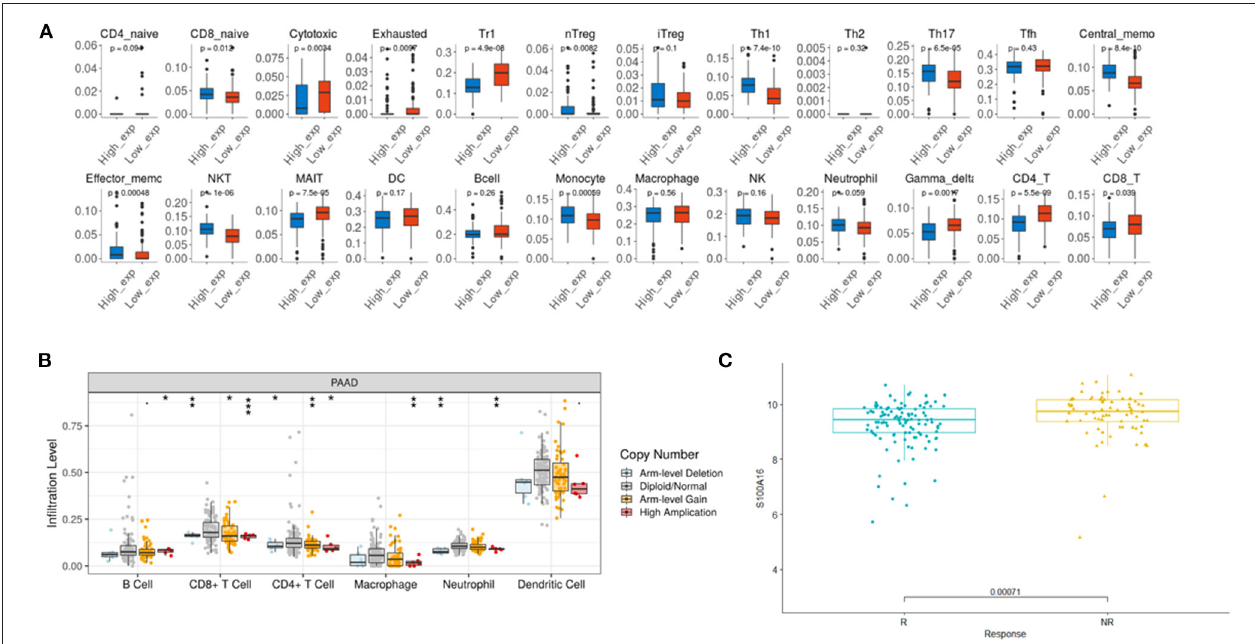
FIGURE 14 | Immune CellAI for S100A16 based on the TCGA database. (A) The relationship between the S100A16 copy number variation and infiltration level. * P < 0.05; ** P < 0.01; *** P < 0.001 (B) . ICB response prediction showed the predicted outcome of immune checkpoint treatment response (C)